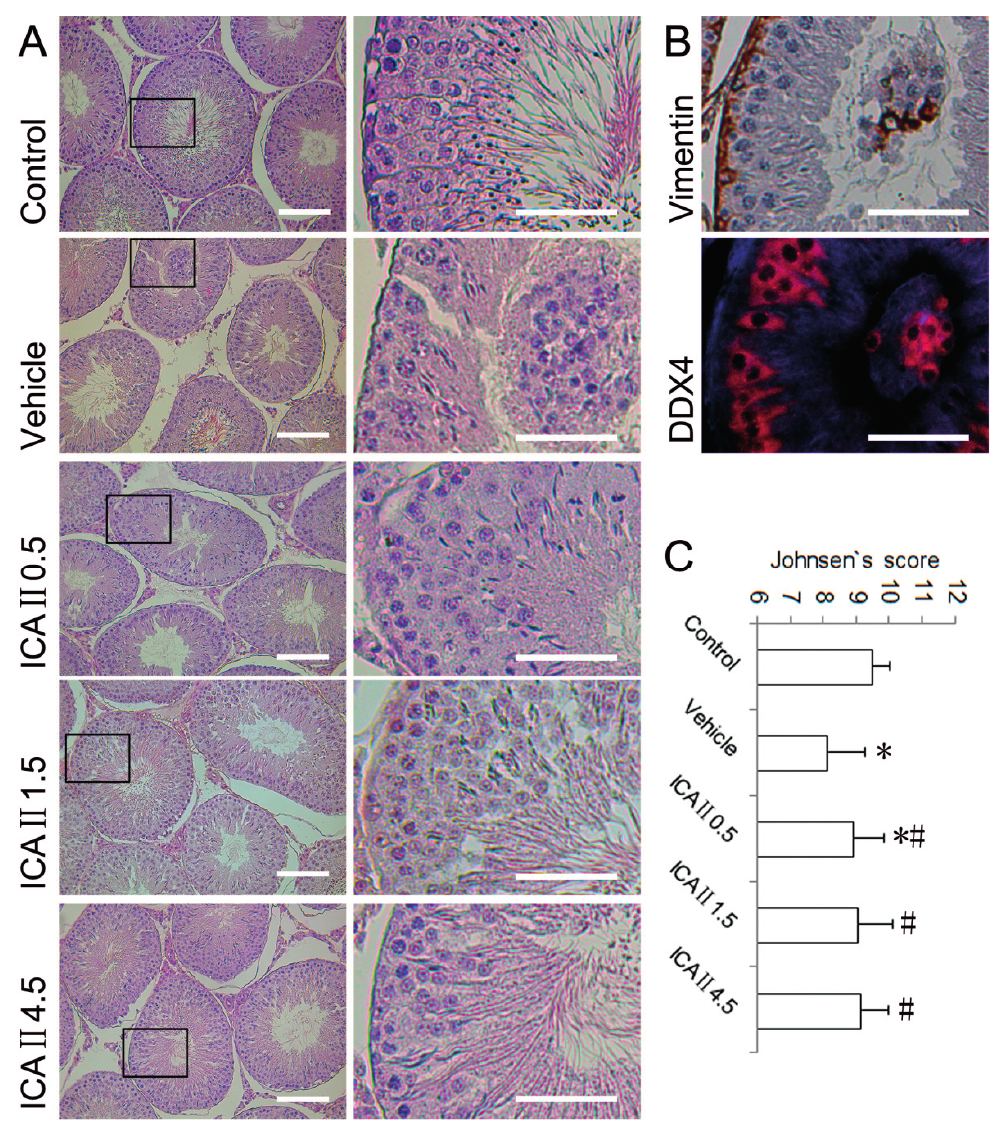
Figure 2. Light microscopy of testicular histopathology in different groups. ( A ) Representative micrographs (haematoxylin and eosin staining) of the testes. Boxed areas in the 200× graphs are shown in the corresponding graphs on the right panels; ( B ) Top : Some detached cells in the lumen of seminiferous tubule are confirmed to be Vimentin (a sertoli marker) positive cell (immunohistochemical staining), 400×; Bottom : Some deciduous cells in the lumen were DDX4 (a germ cell marker, red) positive cells (immunofluorescent staining), 1000×; ( C ) Johnsen’s testicular score. * p < 0.05 compared with the normal control group; # p < 0.05 compared with the vehicle group. Scale bar = 50 μ